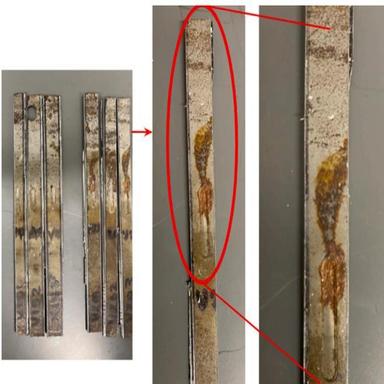
Tensile samples madea. out of sample A.